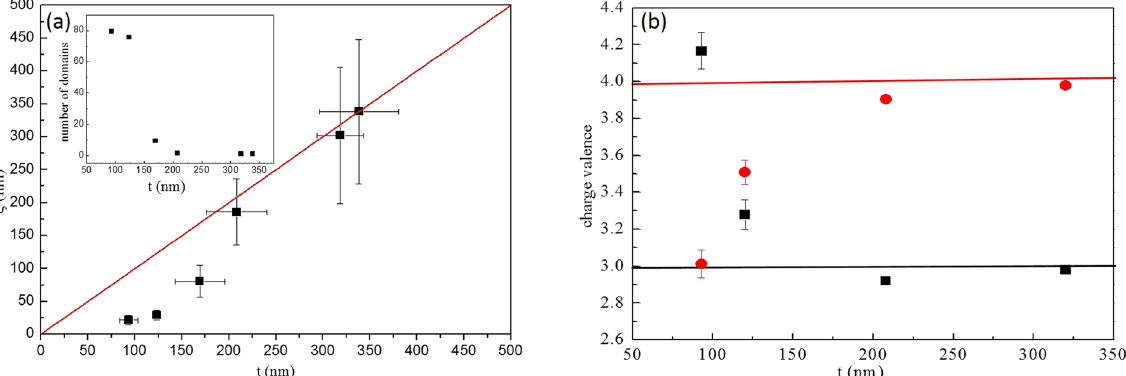
Figure 2. Variation of pyrochlore domains ξ ( a ) and valencies of La and Zr cations ( b ) versus grain size. From the joint refinements of X-ray and neutron diffraction powder patterns, the evolution of La (black squares) and Zr (red dots) valences are plotted versus grain size ( b ) and compared with their nominal values (full